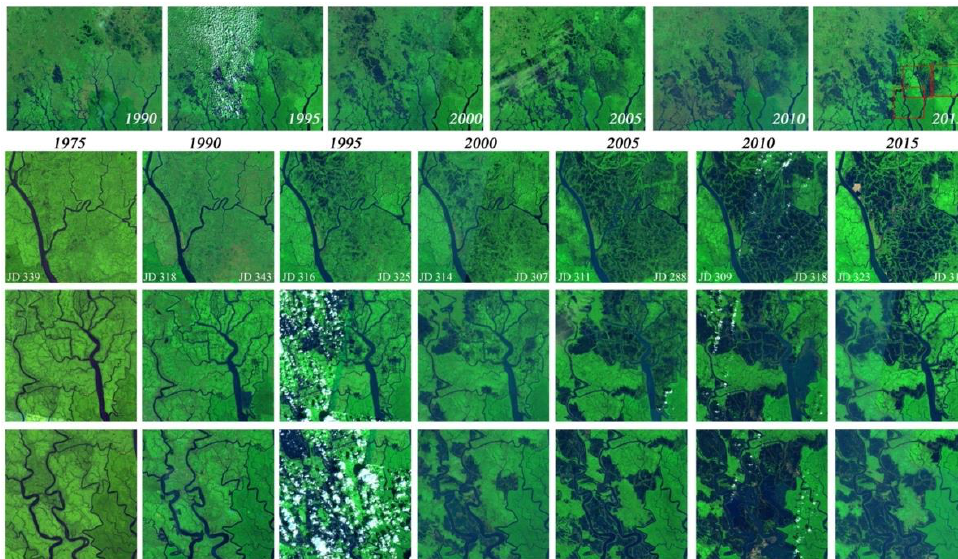
Figure 7. Dry season false color composite images of the lower GBD acquired by MSS, TM, ETM+, and OLI sensors onboard Landsat 2 – 8. Starting with 1990, spatially coherent expansion in extent of standing water clearly occurs over large portions of the lower GBD. Between 2010 and 2015, reconversion is observed in some areas as land cover transitions from aquaculture back to green vegetation. Both progressive and abrupt changes exist. Some regions gradually expand in spatial extent of dry season aquaculture, while others transition rapidly to their full area. Both smallholder and large, industrial-scale aquaculture operations are present. All images are false color composites. For the 1975 images, red = visible red reflectance; green = NIR reflectance; blue = visible blue reflectance (MSS bands 5, 6, and 4). For the 1990 – 2015 images, red = SWIR reflectance; green = NIR reflectance; blue = visible reflectance (TM bands 6, 4, and 2 or OLI bands 7, 5, and 3).